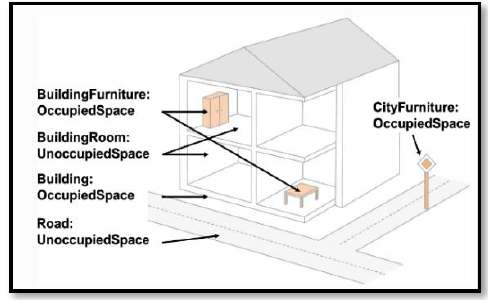
Figure 5 : Representation of a carport as Occupied Space in different LODs. (Kutzer et al.,